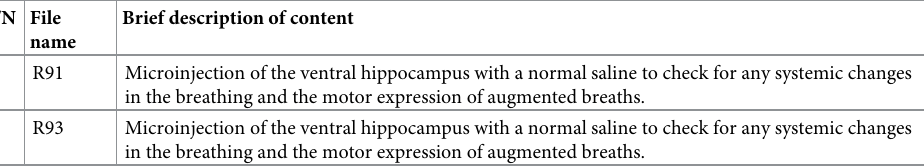
Table 3. Raw tracing Data files for the Vehicle injection into the ventral hippocampus (n = 2). Each file represents a separate animal. S/N File name